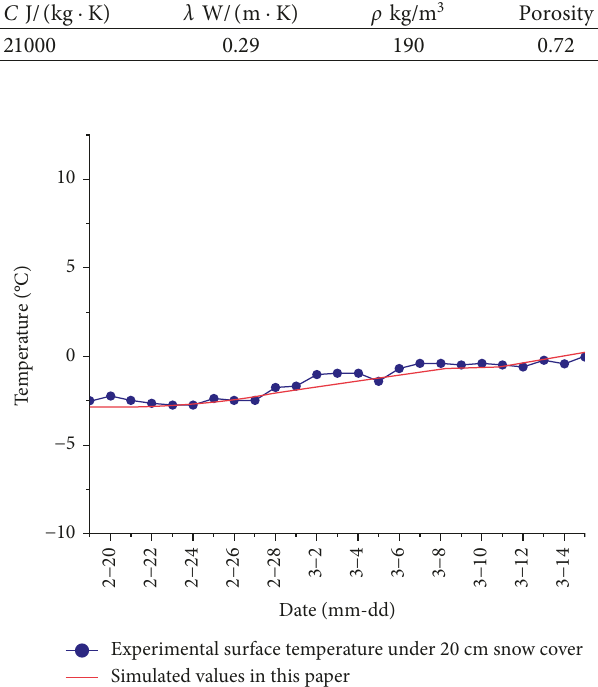
Figure 1: Surface temperature with and without snow